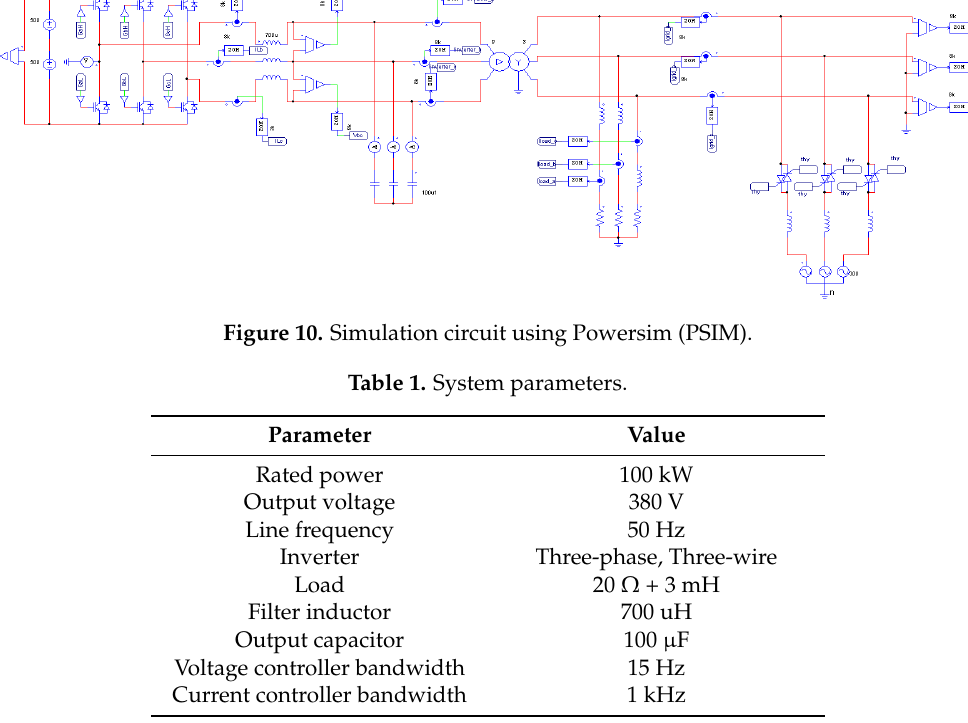
Figure 10. Simulation circuit using Powersim (PSIM).